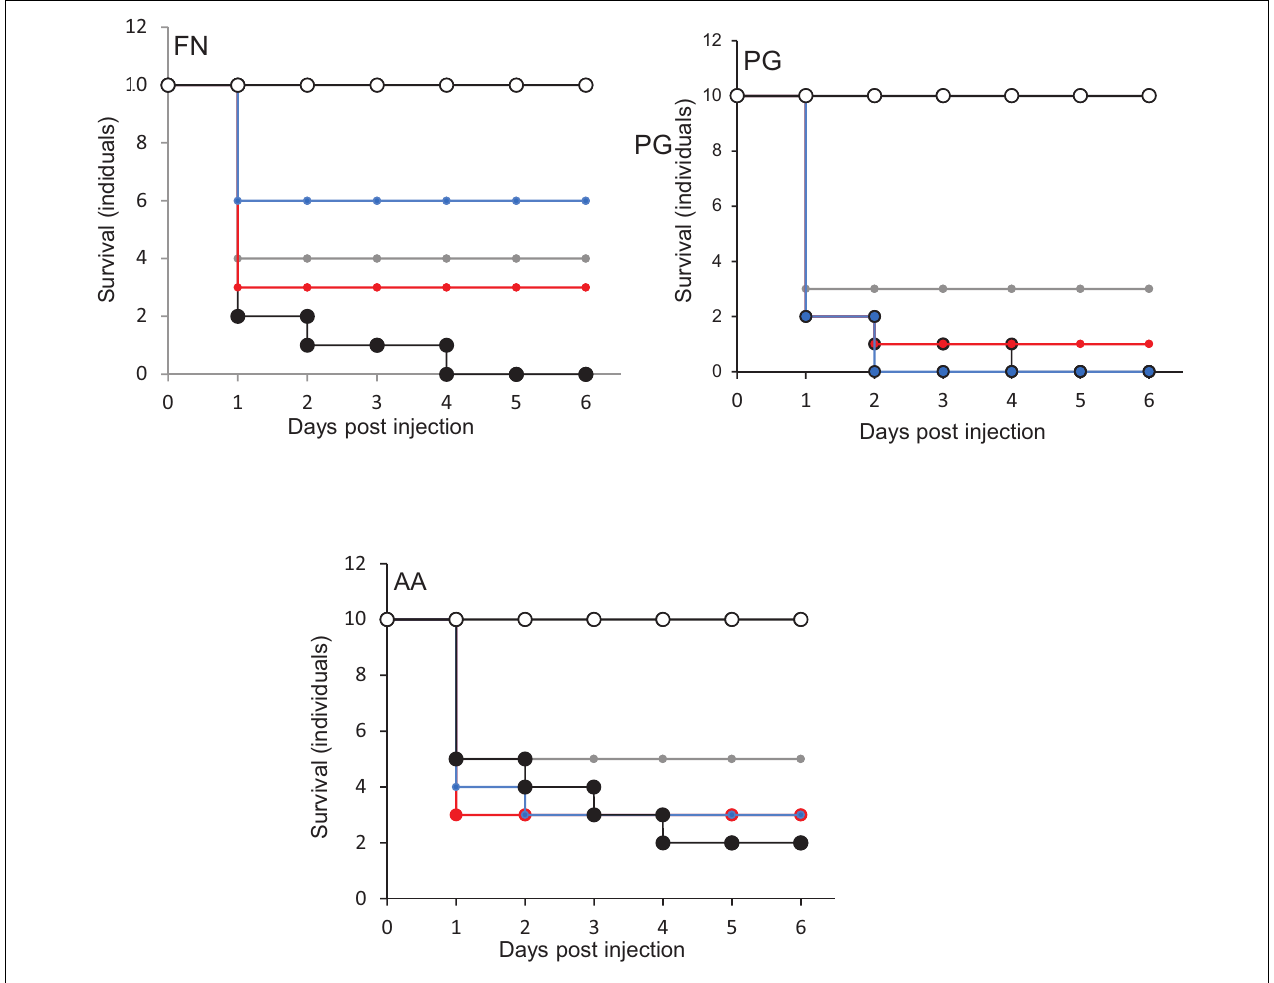
FIGURE 6 | Protection of larvae conferred by candidate probiotics following simultaneous administration of periodontal pathogens into the different larval prolegs. Pathogen only (black symbols) and PBS (white symbols). Pathogen administered simultaneously with L. rhamnosus (gray symbols), L. reuteri (red symbols), or S. salivarius (blue symbols). All experiments were done twice on 2 consecutive weeks, with different batches of larvae and with three replica plates where each plate contains 10 larvae. The greatest protection against F. nucleatum was conferred by S. salivarius K-12. For P. gingivalis and A. actinomycetemcomitans . L. rhamnosus GG was the most protective